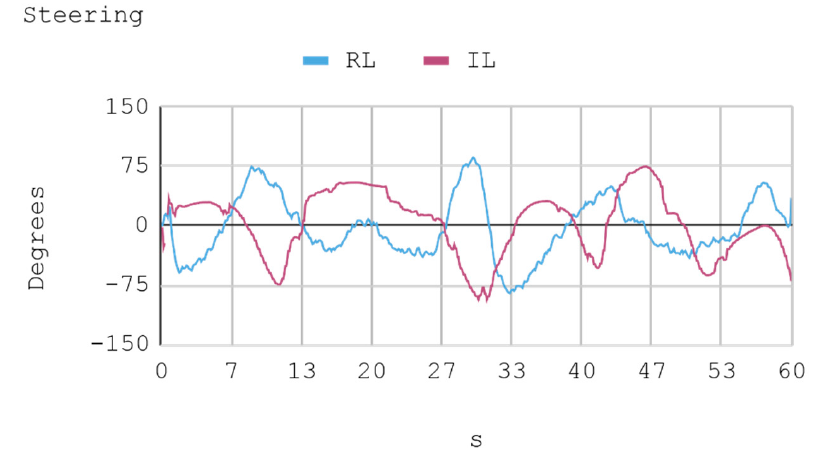
Figure 13. Case 2. Automobile’s torque and steering.